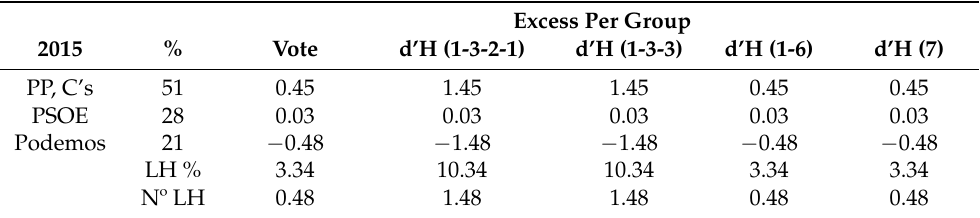
Table 14. Excess per group—absolute Indices of disproportionality, according to the d’Hondt distri- butions and the number of seats non-proportionally allocated in the X Legislature. Excess Per